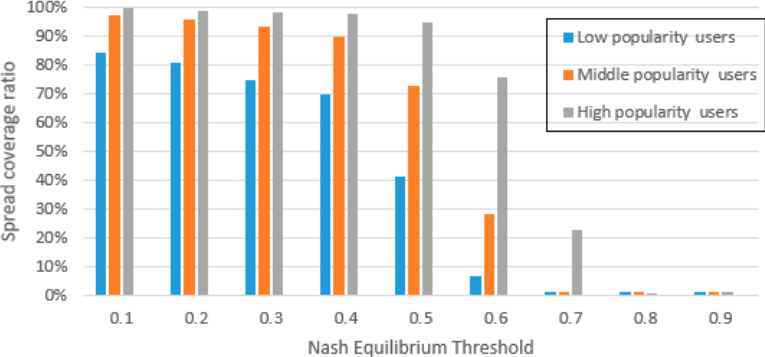
Figure 8. Range of dissemination vs. popularity under different Nash equilibrium thresholds.